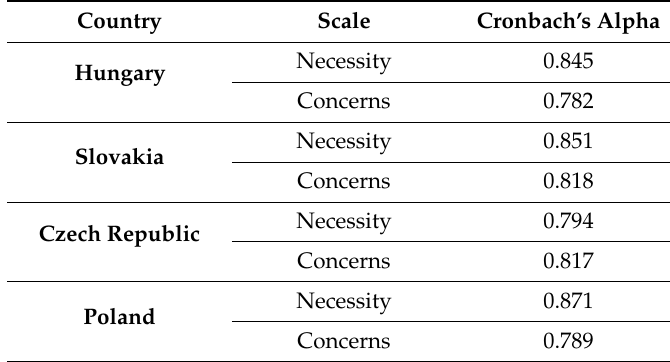
Table 3. Internal reliability of the two scales.